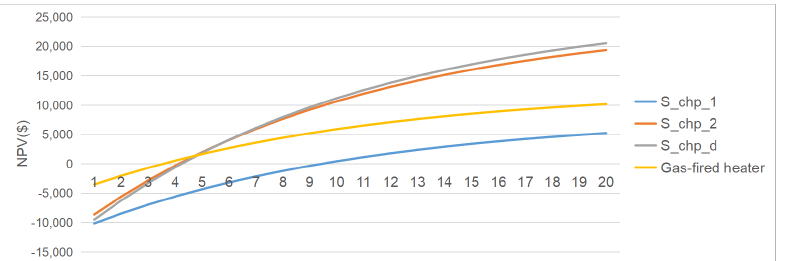
Figure 8. Comparison of NPV for CHP in different control strategies and domestic gas-fired heater.